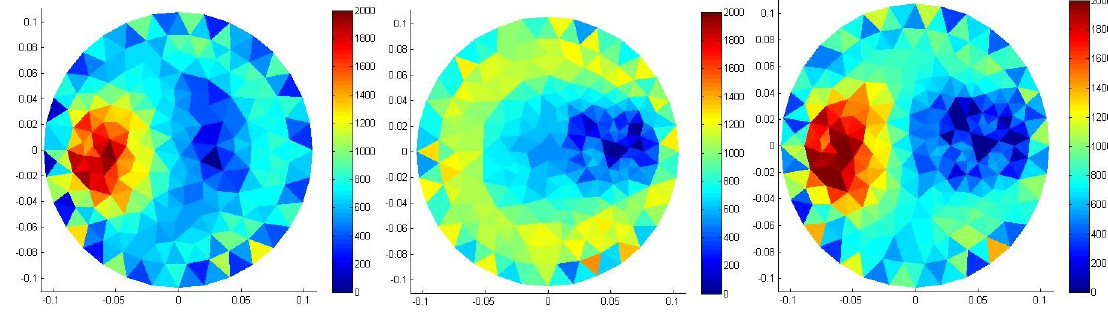
Figure 13: Reconstruction image of the Newton-Raphson method in non-uniform elements